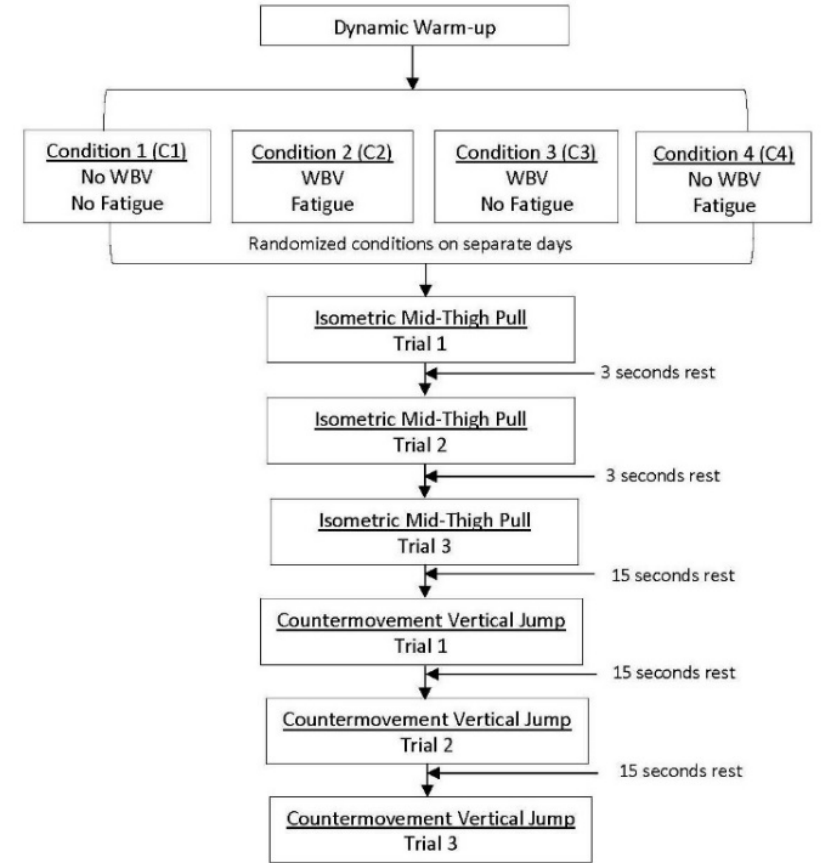
Figure 1. Testing protocol.